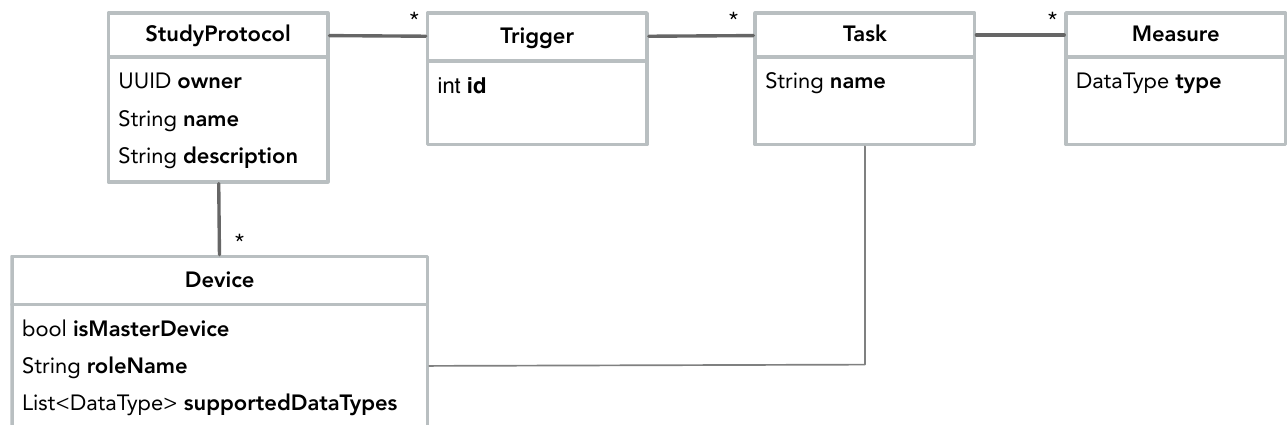
Figure 6. The UML class diagram of the StudyProtocol domain model. *: